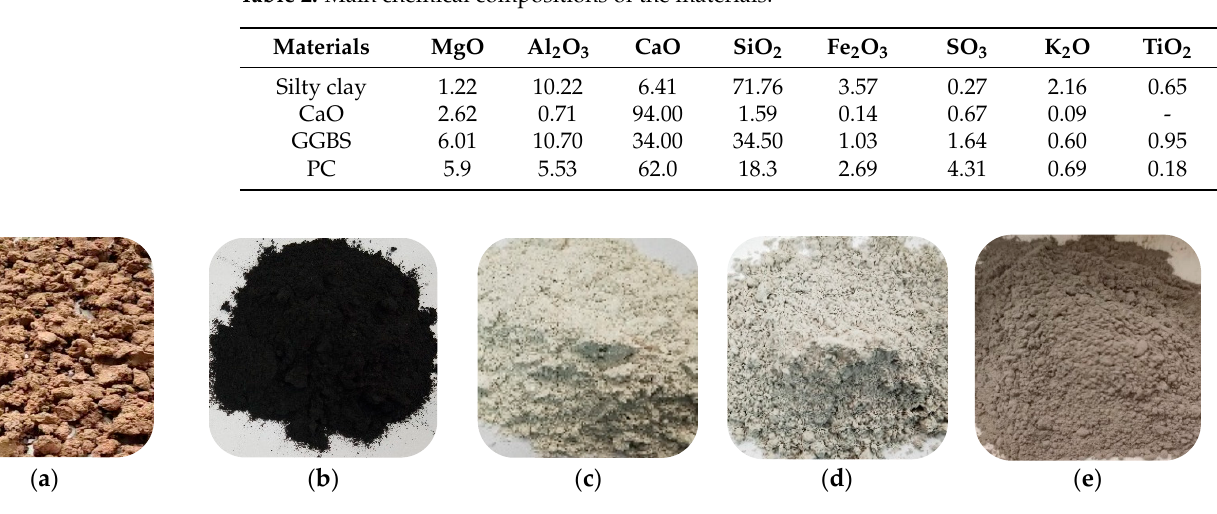
Figure 1. Appearance of all materials. ( a ) Soil, ( b ) OM, ( c ) CaO, ( d ) GGBS, and ( e ) PC.